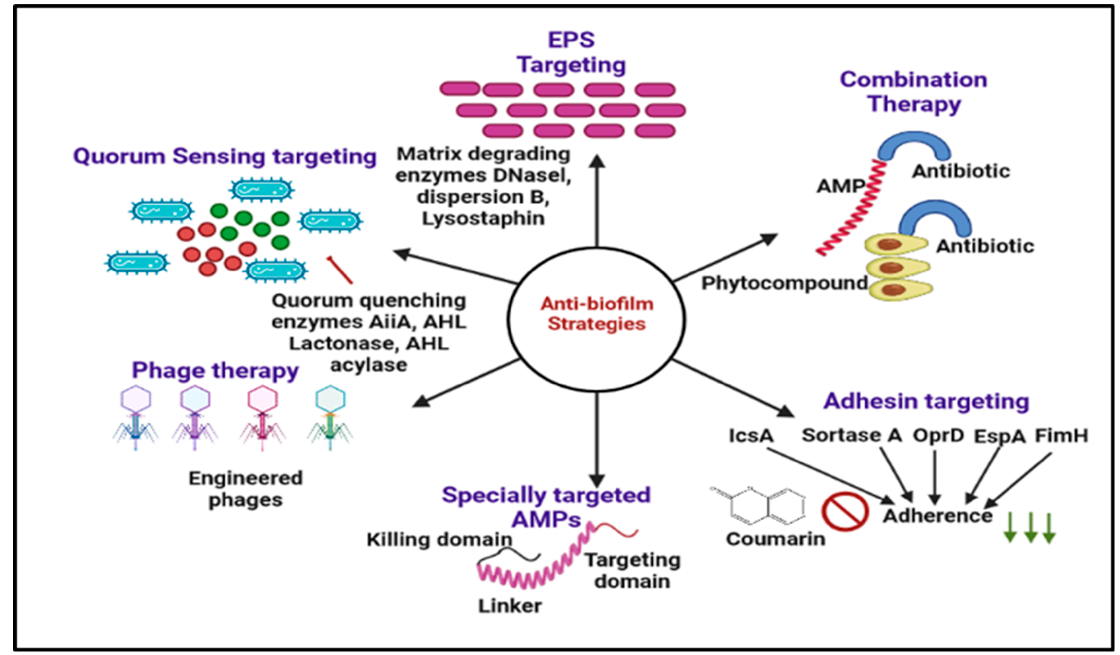
Figure 6. Graphical illustration of the different antibiofilm approaches discussed in this review. EPS targeting (DNaseI, dispersion B, lysostaphin), Phage therapy, nanotechnology, chitosan and derivatives, and antimicrobial peptides .